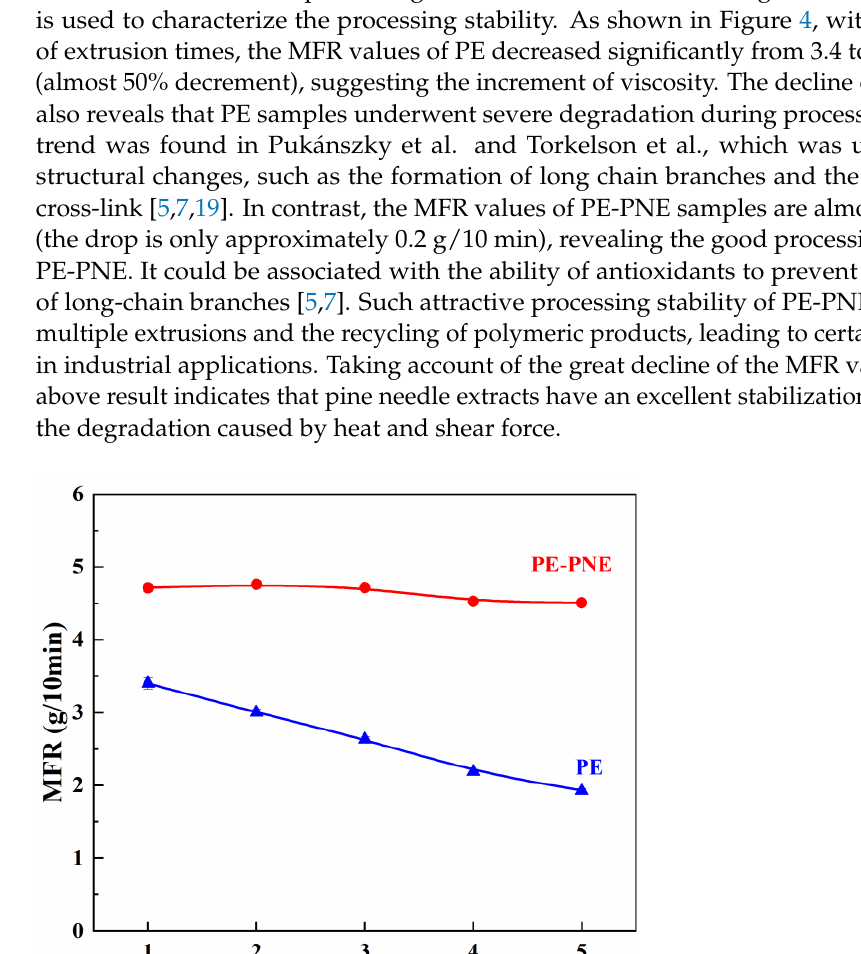
Figure 5. Tensile strength and Elongation at break of PE and PE-PNE samples vs. the number of extrusions. 4. Conclusions